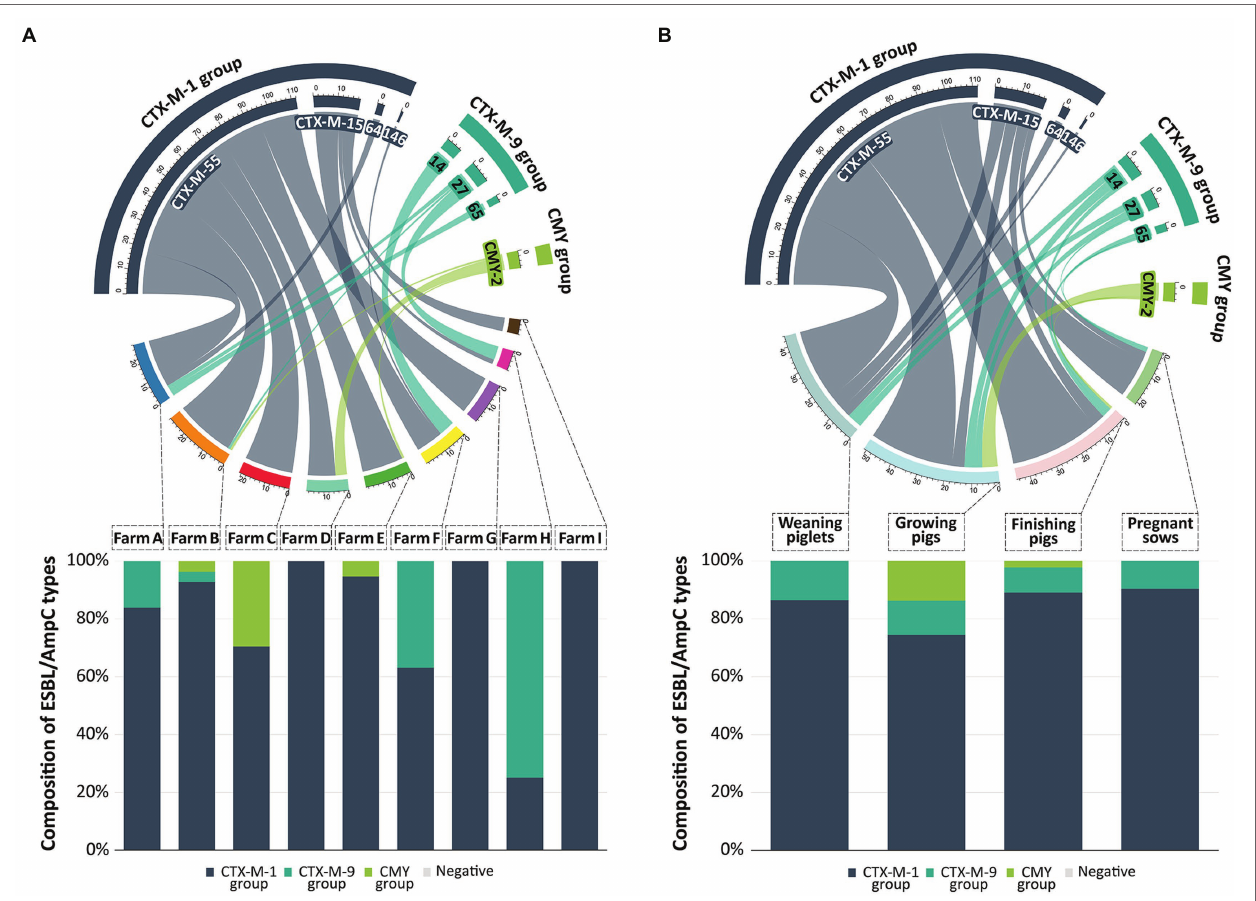
FIGURE 4 | Prevalence and distribution of ESBL/AmpC types from swine farms. In the chord diagram, the size of segments on the top represent the number of ESBL/AmpC-EC isolates with a specific ESBL/AmpC types. Size of segments on the bottom represent the number of ESBL/AmpC-EC isolates detected in different farms (A) and production stages (B) . Ribbons connecting the top and bottom segments represent the number of ESBL/AmpC-EC isolates with a specific ESBL/ AmpC type found on the respective farms and production stages. The connected bar chart shows the composition of ESBL/AmpC types based on the number of ESBL/AmpC-EC isolates in different farms (A) or production stages (B) . The chord diagram and bar chart were generated with R software (ver.